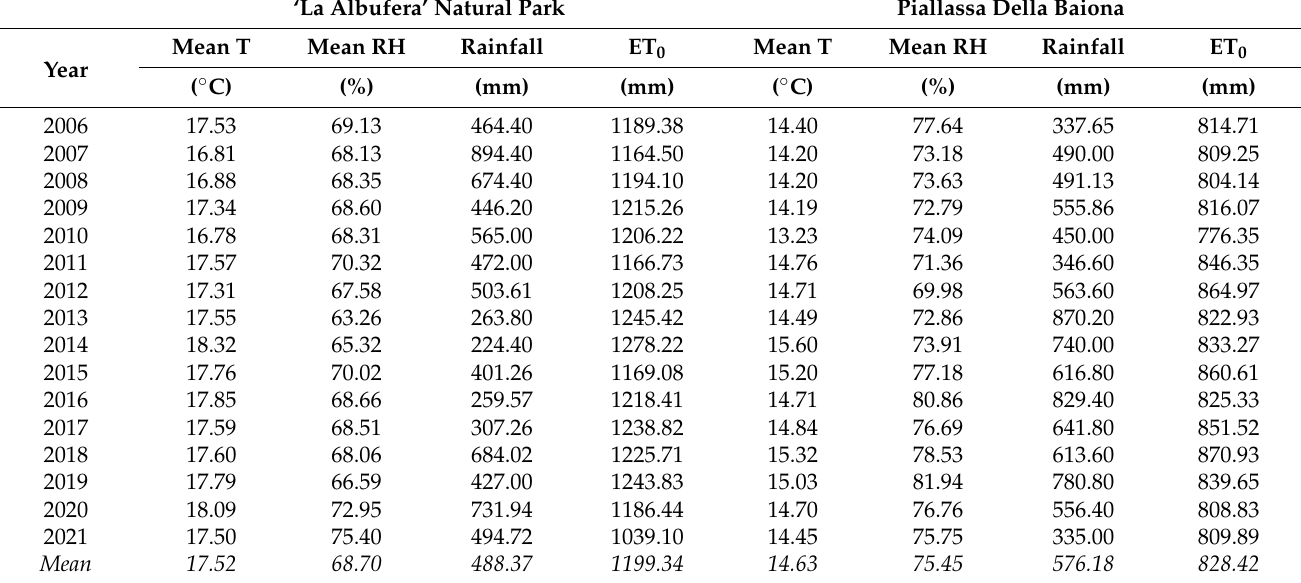
Table 2. Historical weather data (from 2006 to 2021) of the areas of ‘La Albufera’ Natural Park (Spain) and Piallassa della Baiona (Italy), provided, respectively, by the Spanish Agroclimatic Information System for Irrigation (SIAR) and the Italian Arpae-Simc meteorological network [71,72]. T: tem- perature; RH: relative humidity; Eto: evapotranspiration. Eto data of Piallassa della Baiona were calculated applying the Thornthwaite method